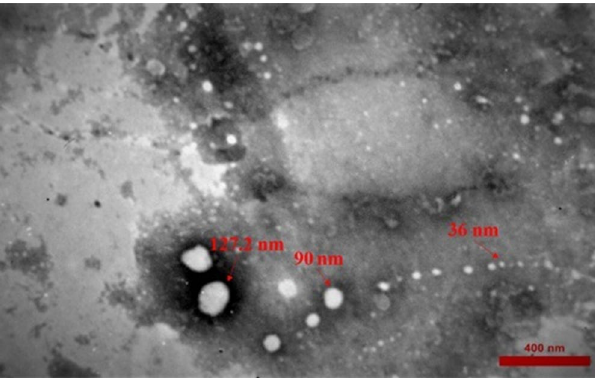
Figure 1. Morphological characterization of A. muciniphila -derived EVs. The TEM image of negatively stained EVs indicated different sizes (range: 30–150 nm) and vesicle-like structure of EVs (scale bar: 400 nm).